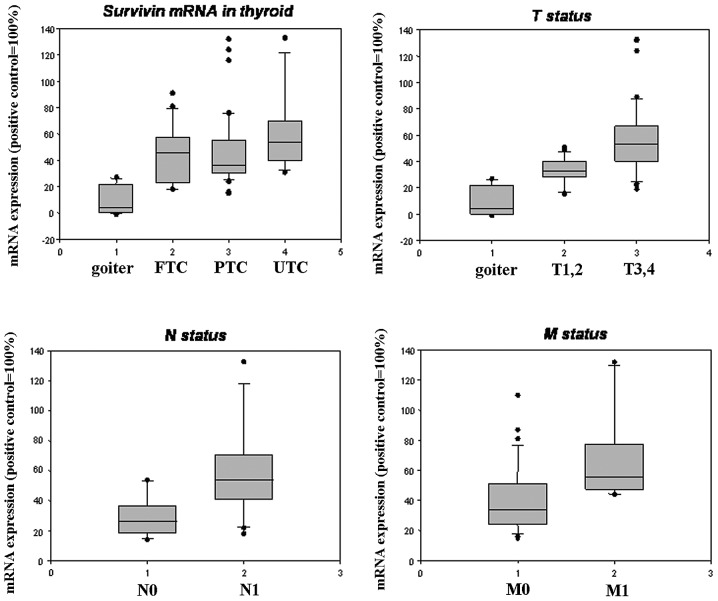
Correlation between the transcript expression of endogenous survivin and various clinicopathological parameters. Thyroid cancer samples expressed higher transcript expression of endogenous survivin when compared to the benign goiters; the expression was significantly correlated with the grade of tumor invasiveness (pT), local lymph node metastasis (N) and distant metastasis (M) of the thyroid carcinoma tissues.